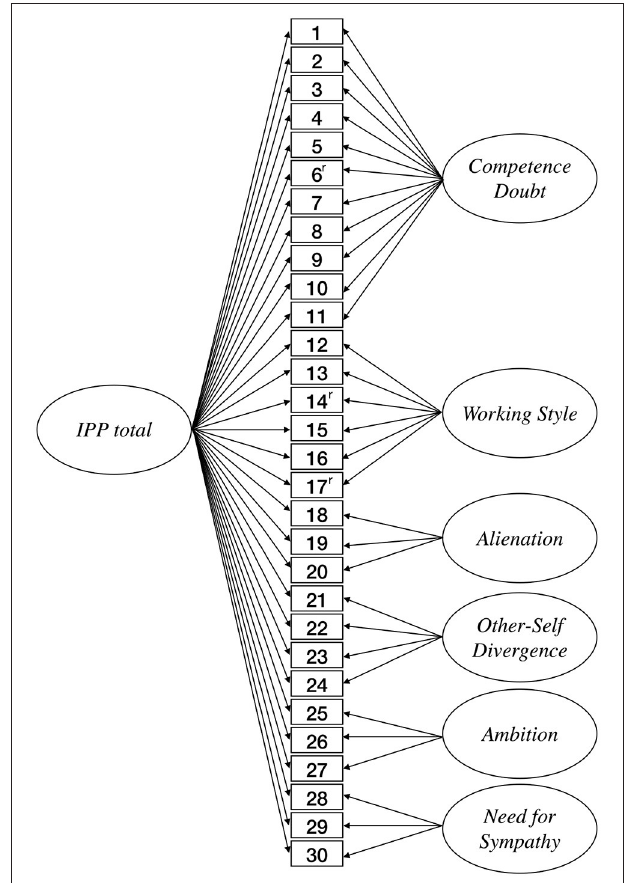
FIGURE 1 | The bifactor model of the